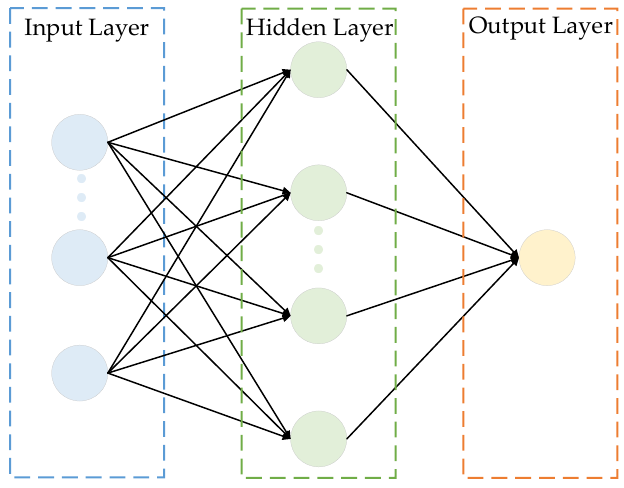
Figure 8. Three-layer